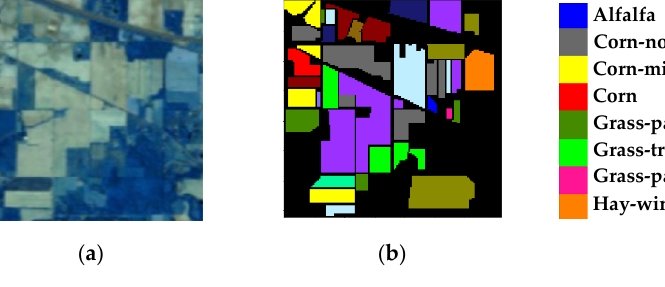
Figure 5 . Indian Pines Data Set (( a ) False-color map; ( b ) Ground-truth map). Figure 5. Indian Pines Data Set (( a ) False-color map; ( b ) Ground-truth map). Table 2. Number of training and test sets for the Indian Pines data set. Table 2. Number of training and test sets for the Indian Pines data